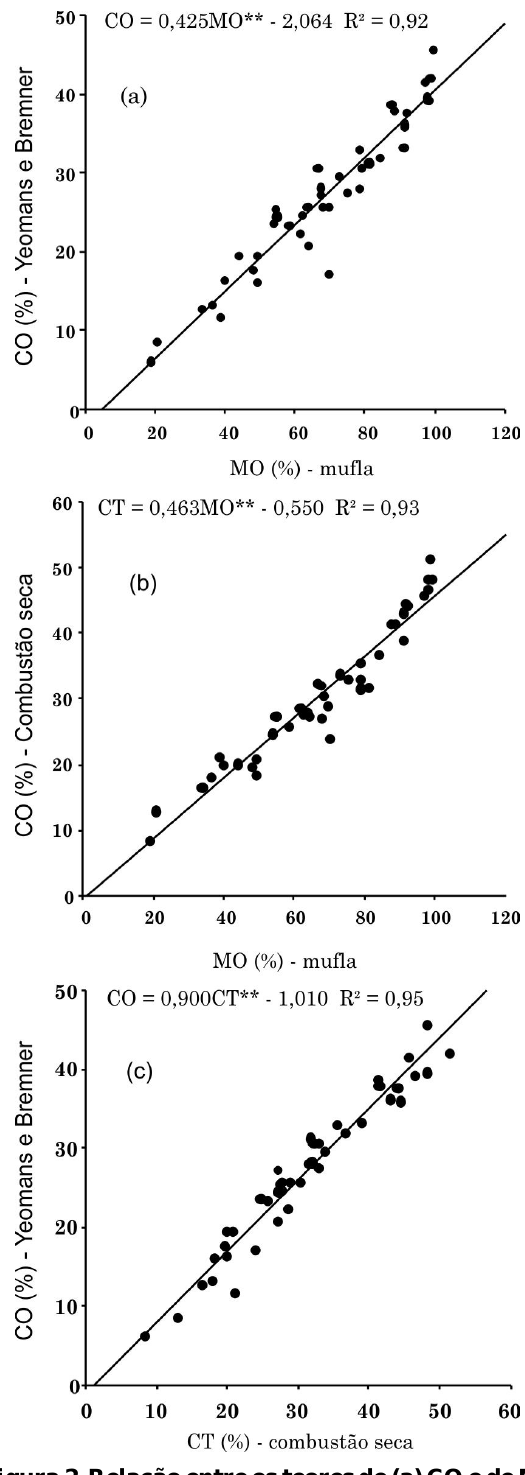
Figura 2. Relação entre os teores de (a) CO e de MO, (b) CT e MO e (c) CO e CT, obtidos pelos métodos de Yeomans & Bremner, da mufla e da combustão seca, para os teores de CO, MO e CT, respectivamente, para as 42 amostras de resíduos orgânicos analisadas. CO = carbono orgânico, CT = carbono total e MO = matéria orgânica. **: significativo a p <